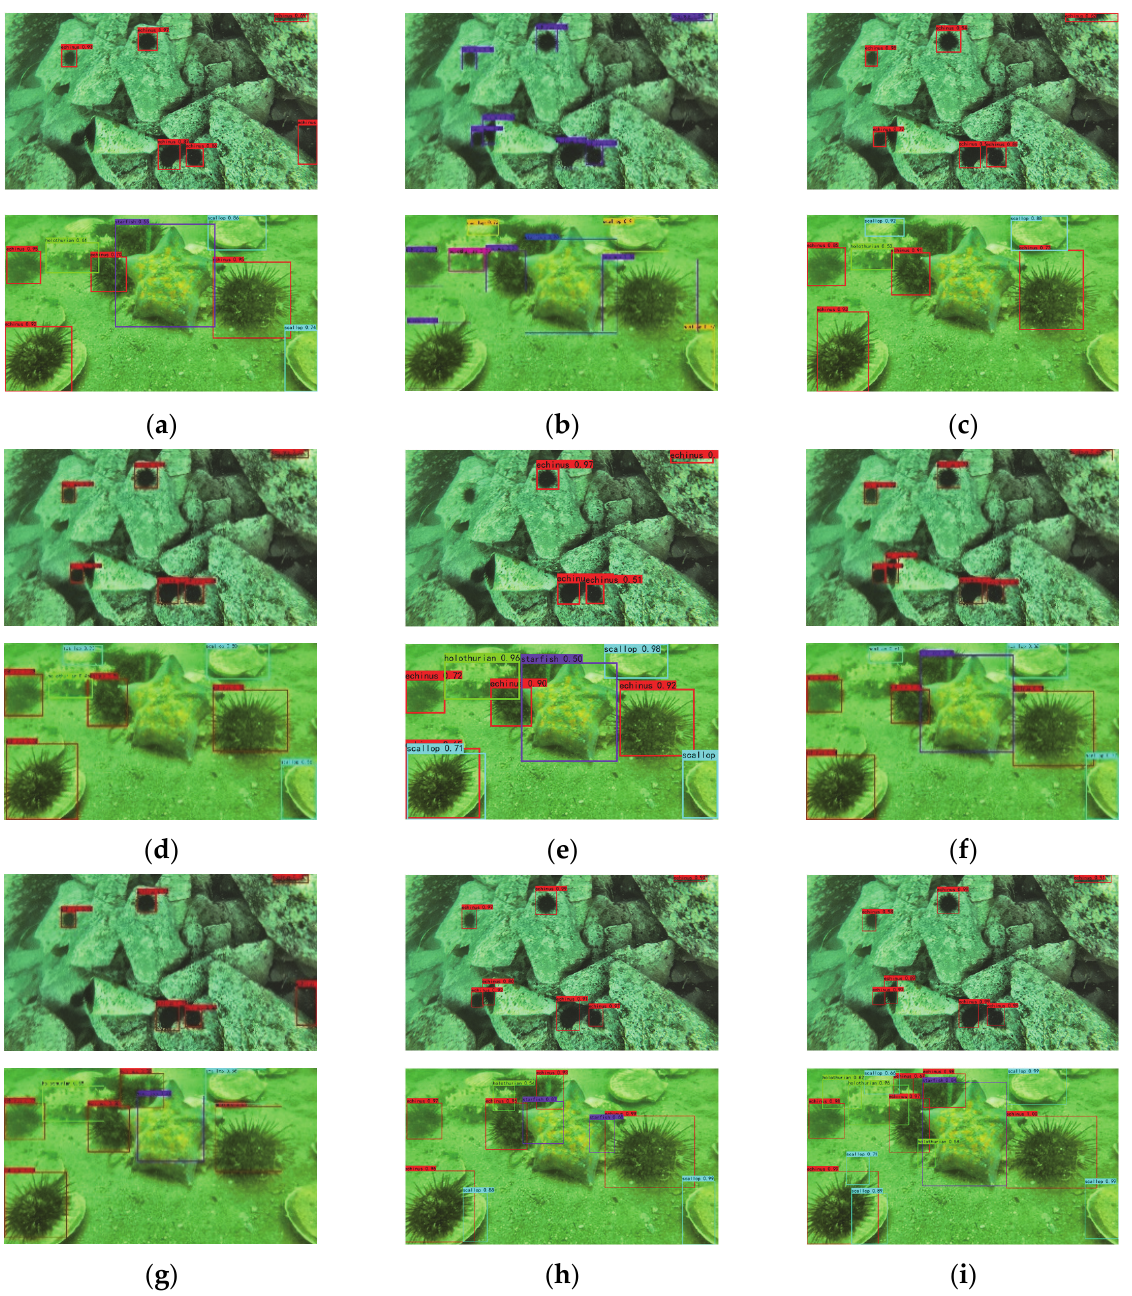
Figure 13. Visualization detection results of different algorithms on single ‐ category and multi ‐ category objects. From the first column to the fifth column: ( a ) Faster R ‐ CNN’s result; ( b ) Faster R ‐ CNN ‐ FPN’s result; ( c ) SSD’s result; ( d ) Mobile ‐ SSD’s result; ( e ) YOLOv4 ′ s result; ( f ) CenterNet’s result; ( g ) RetinaNet’s result; ( h ) EfficientDet’s result; ( i ) EDR’s result.